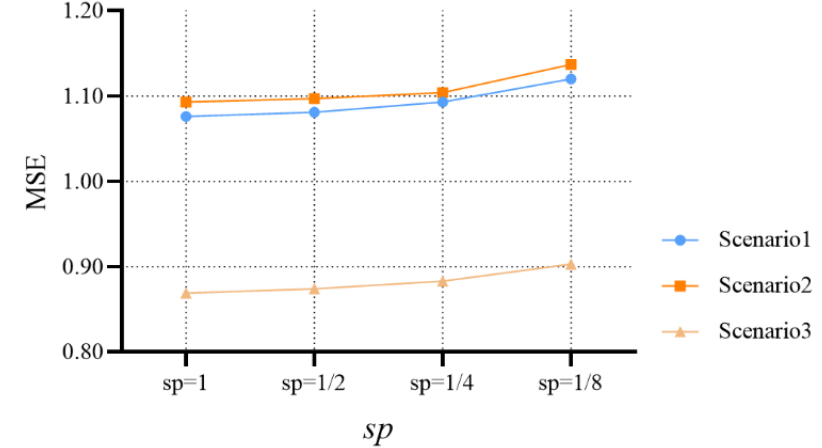
Figure 5. Effect of the sparsity degree sp of the source domain.